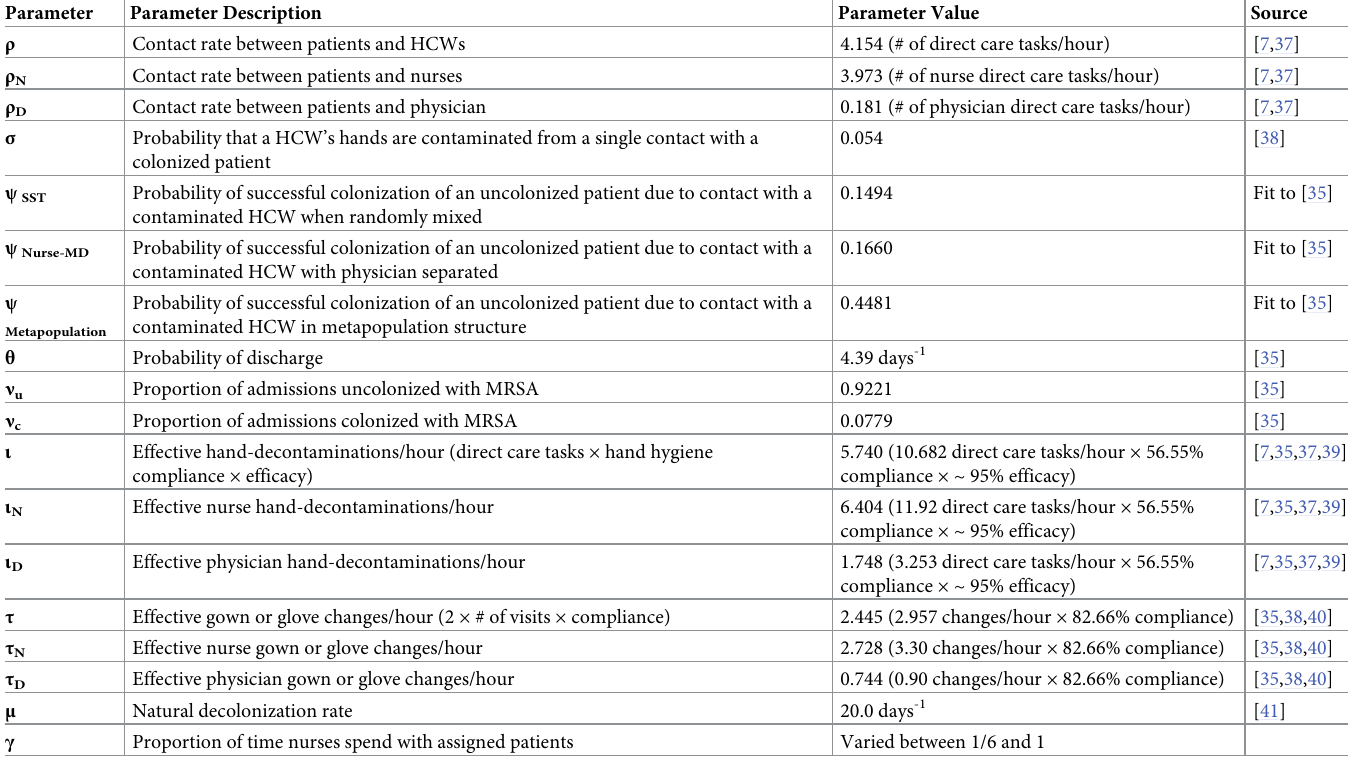
Table 1. Parameters for modeling the acquisition of methicillin-resistant Staphylococcus aureus in an Intensive Care Unit. Parameter Parameter Description Parameter